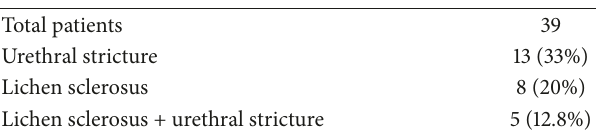
Total patients 39 Urethral stricture 13 (33%) Lichen sclerosus 8 (20%) Lichen sclerosus + urethral stricture 5